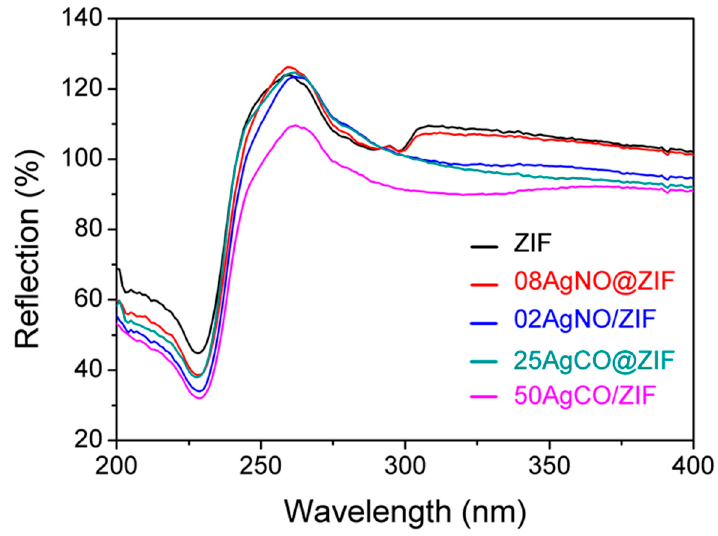
Figure 3. UV-Vis spectra of ZIF-8 samples: ZIF (as-synthesized ZIF-8), 08AgNO@ZIF (de novo), 02AgNO/ZIF (impregnation), 25AgCO@ZIF (de novo), and 50AgCO/ZIF (impregnation).